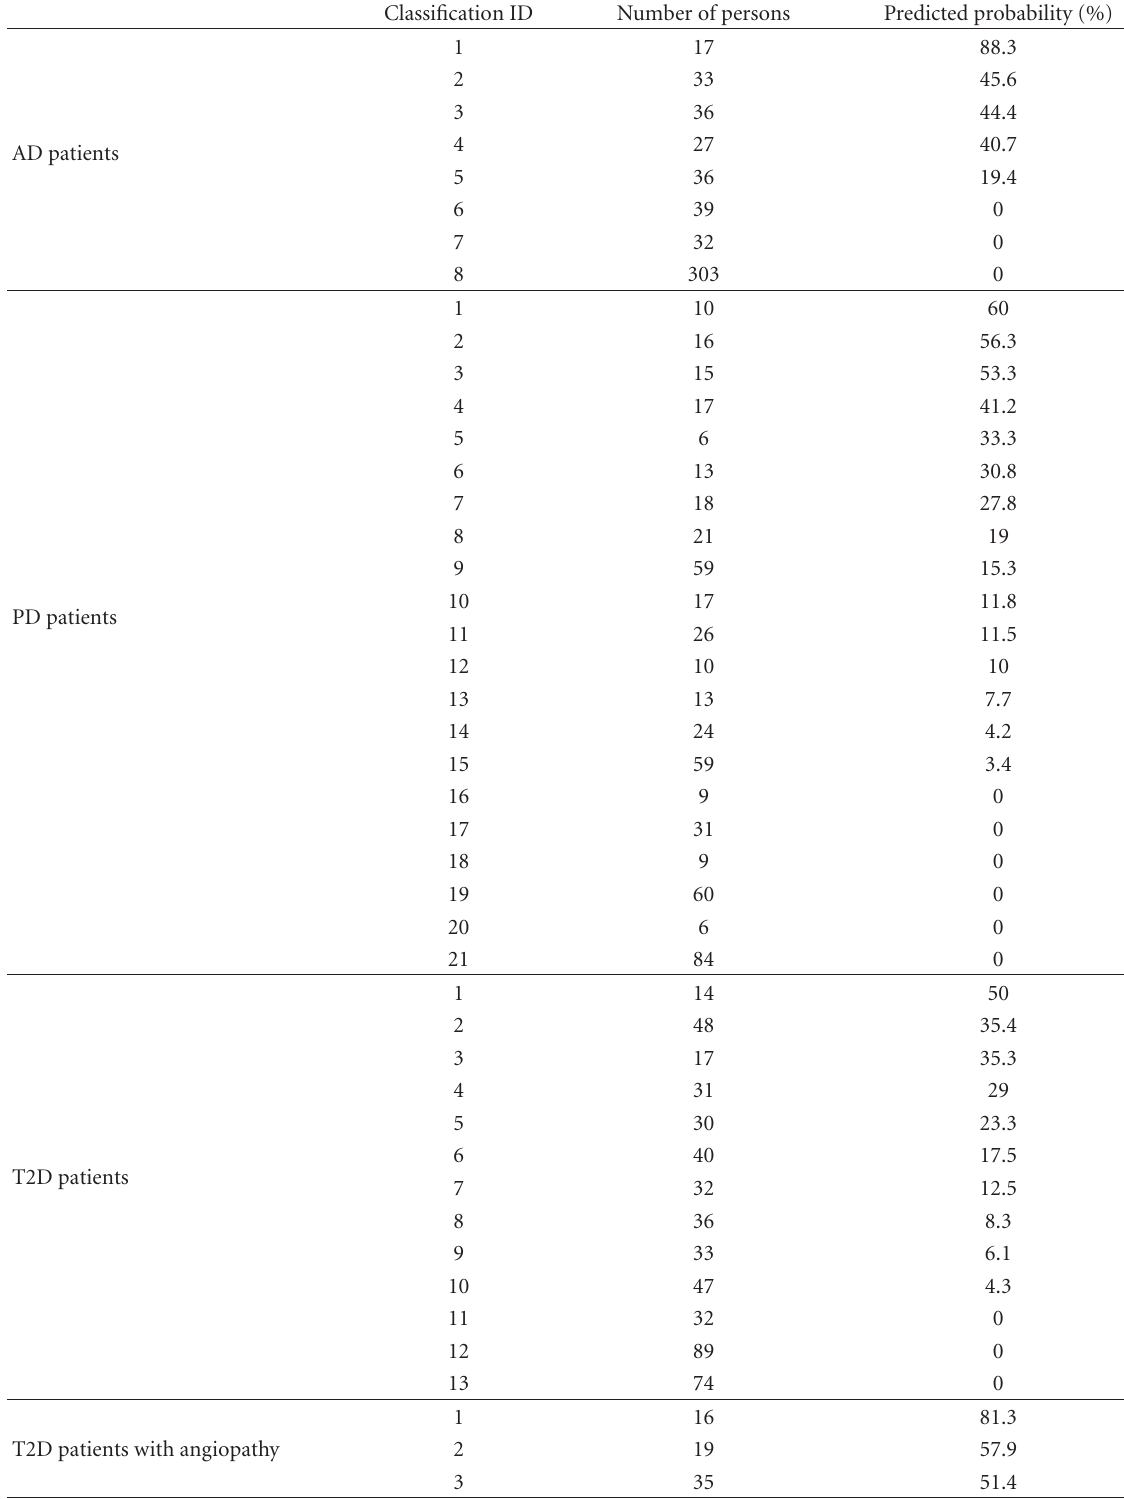
Table 1: mtSNP classifications for the AD